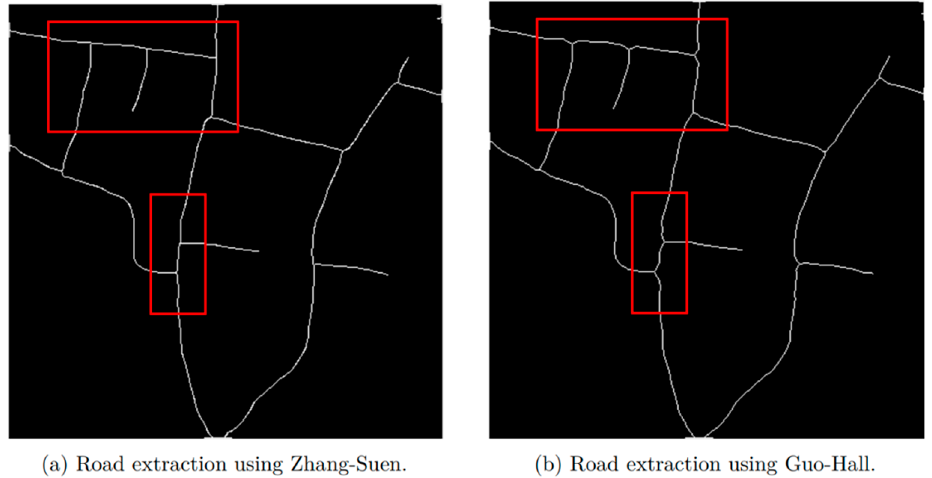
Figure 13. A sample comparison between the Zhang–Suen and the Guo–Hall thinning